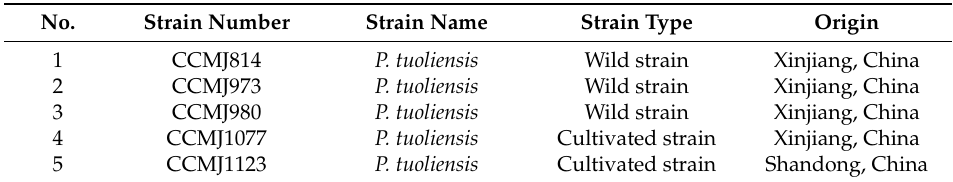
Table 1. Information about the five strains of Pleurotus tuoliensis used for isolating protoplast-derived monokaryons in this study.